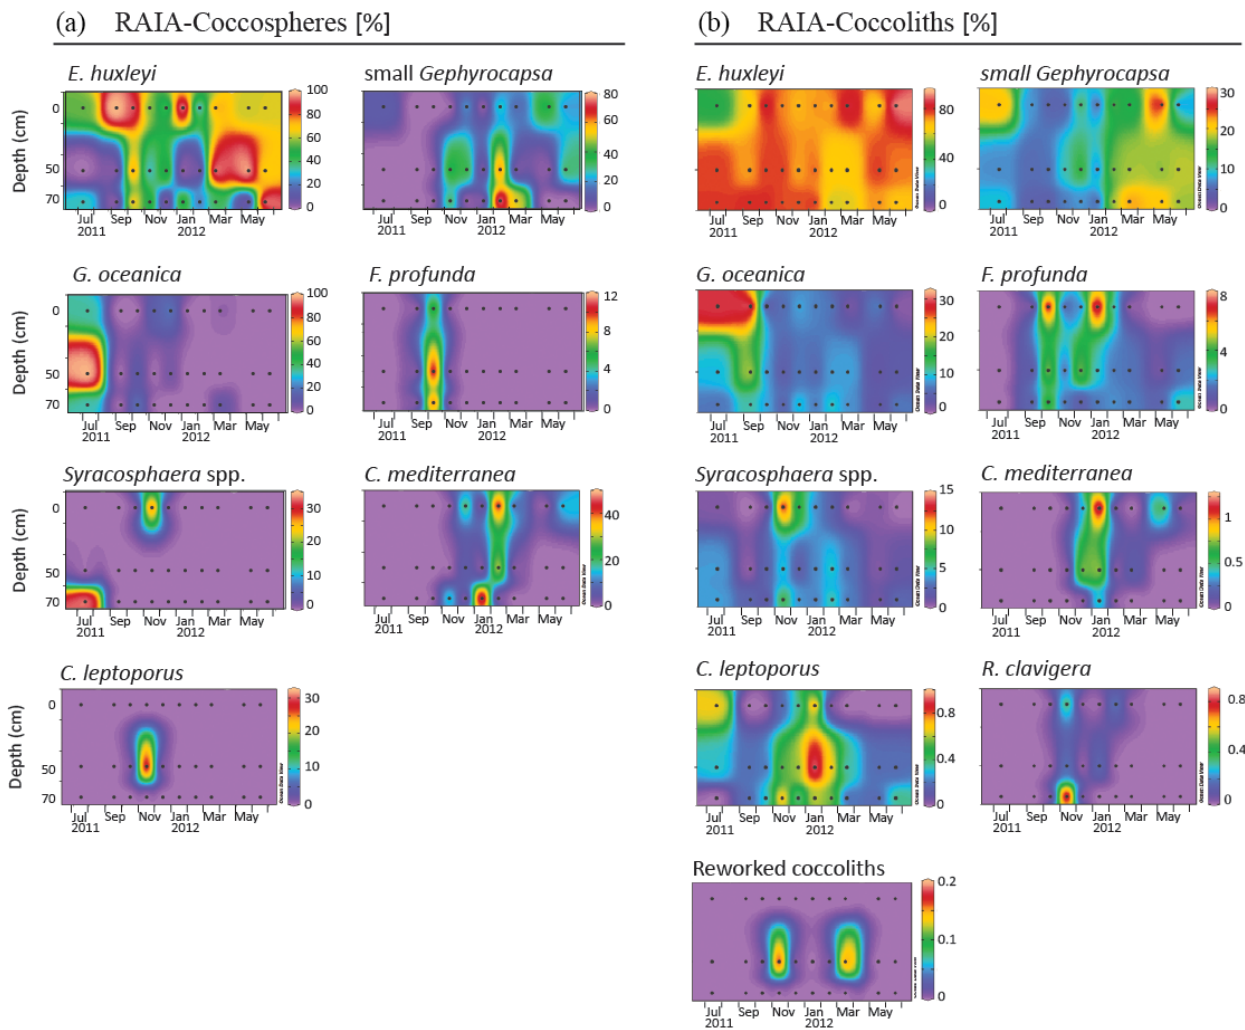
Figure 4. Relative abundance (%) of major species of coccospheres (a) and coccoliths (b) in RAIA station. Black dots represent the sampling month and depth. Note that each colour bar has been scaled to the maximum and minimum values of its corresponding